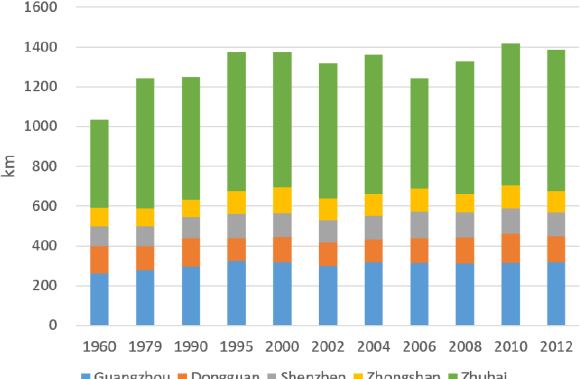
Figure 2. Change of coastline length in the PRD (1960~2012)